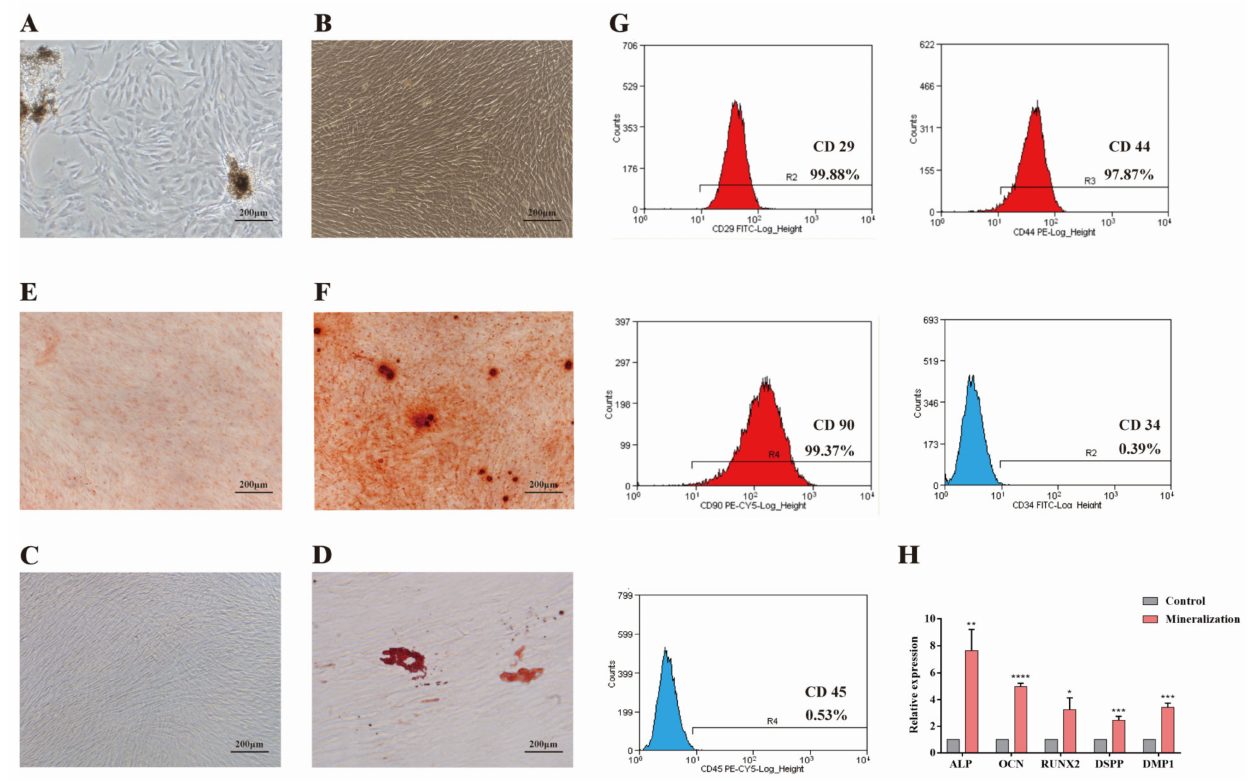
Figure 1. Culture and identification of hDPSCs. ( A , B ) Primary cultured and passage hDPSCs. ( C , D ) Oil red O staining of hDPSCs showed that no lipid droplet was observed in the undifferentiated hDPSCs group but a few lipid droplets were found in the differentiated hDPSCs group. ( E , F ) Alizarin Red S staining of hDPSCs showed that no obvious nodules in the undifferentiated hDPSCs but obviously more nodules and mineralized matrix were formed in the differentiated hDPSCs group. ( G ) The flow cytometric analysis revealed that hDPSCs were positive for mesenchymal stem cell marker (CD29, CD44, CD90) but were negative for hematopoietic stem cell marker (CD34, CD45). ( H ) mRNA expressions of osteogenic/odontogenic genes ALP, OCN, RUNX2, DSPP and DMP1 were detected by qRT-PCR. All samples were performed in triplicate. The data are represented as means ± SD. * p < 0.05, ** p < 0.01, *** p < 0.001, **** p <